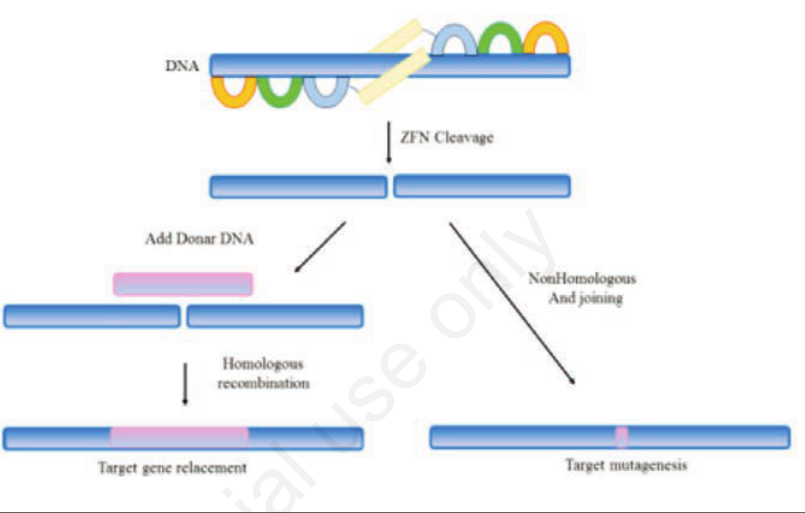
Figure 1. Repair outcomes of a genomic double-strand break, illustrated for the case of ZFN cleavage. A pair of three-finger ZFNs is shown at the top in association with a target gene. If a homologous donor DNA is provided repair can proceed by homologous recom- bination using the donor as template. Alternatively, the break can be repaired by nonho- mologous end joining, leading to mutations at the cleavage site. 5